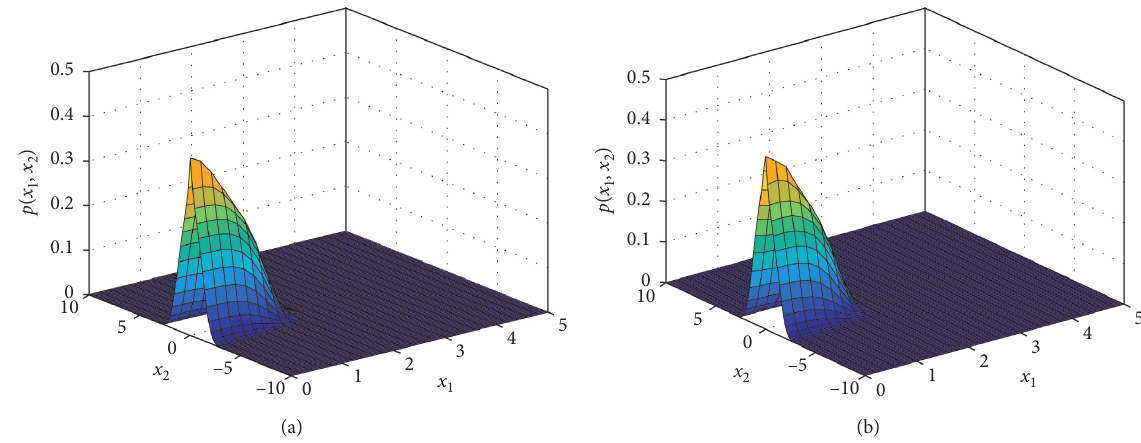
Figure 6: Stationary joint PDFs for displacement x